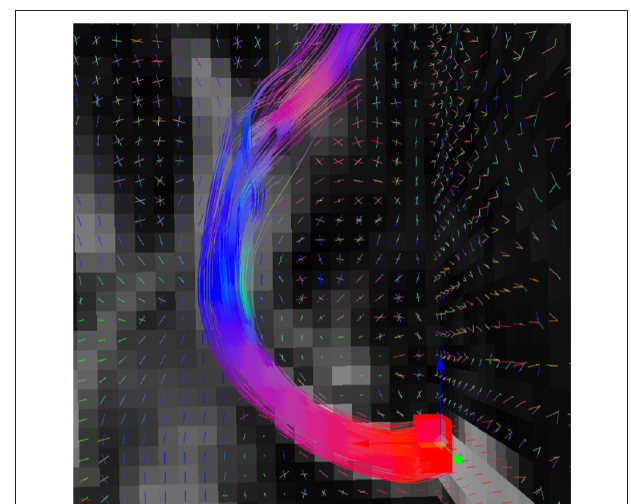
FIGURE 4 | Fiber bundle (part of the corpus callosum), result of the real-time tractography, with the initialization box (red) in the mid-sagittal slice of the CC and the following parameters: angle threshold of 50 ◦ , fiber length minimum of 10mm and maximum of 200mm, FA threshold of 0.1, a step size of 0.5mm, 10 seeds per axis and a puncture value (g) of